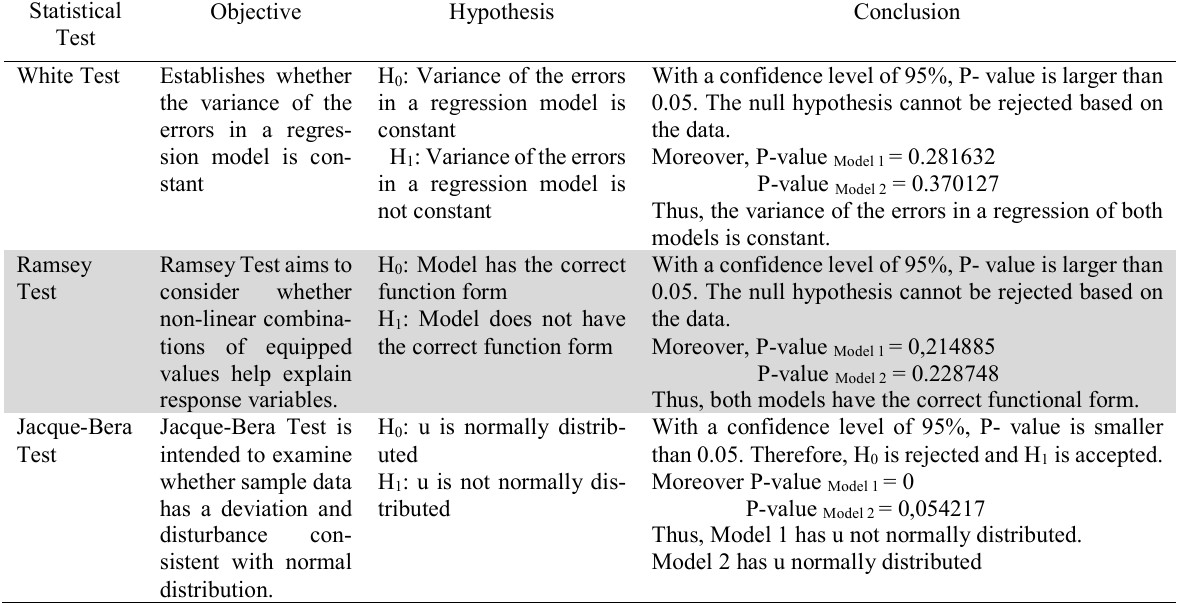
Process validation of the rationality and reliability of regression models